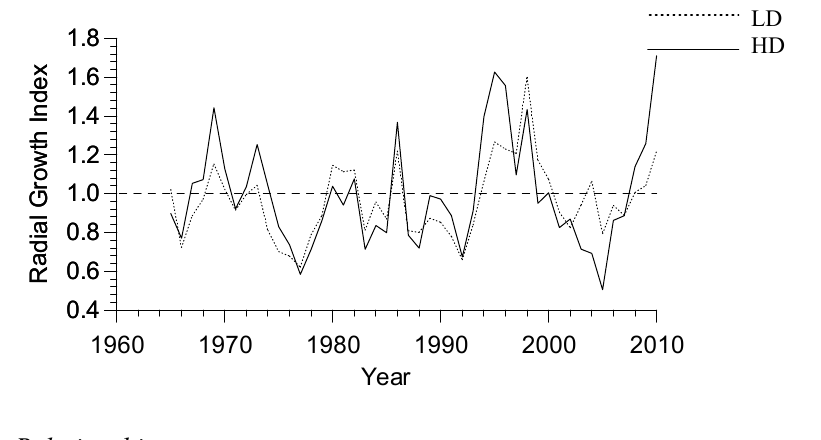
Figure 5. Detrended ring width chronologies of red pine grown in the Huron National Forest, Michigan. LD represents low density stands and HD represents high density